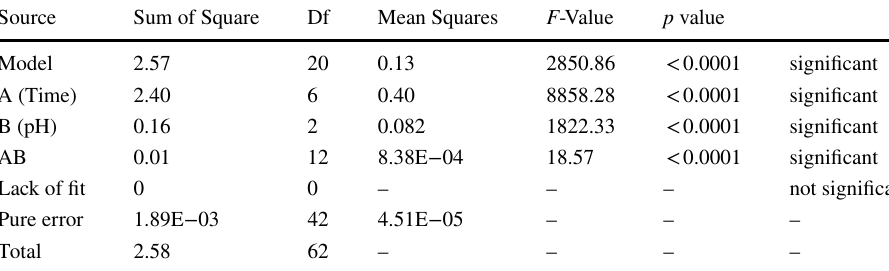
Table 2 Analysis of variance for MO destruction rate by MCT#2